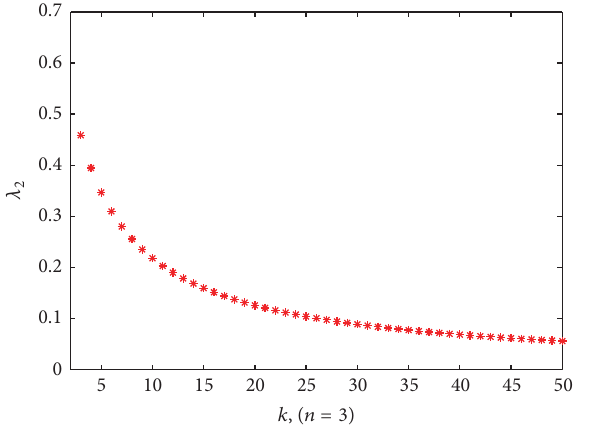
Figure 6: The 𝐻 2 norm for topology 𝐾 3 ∘ 𝑃 𝑘 .